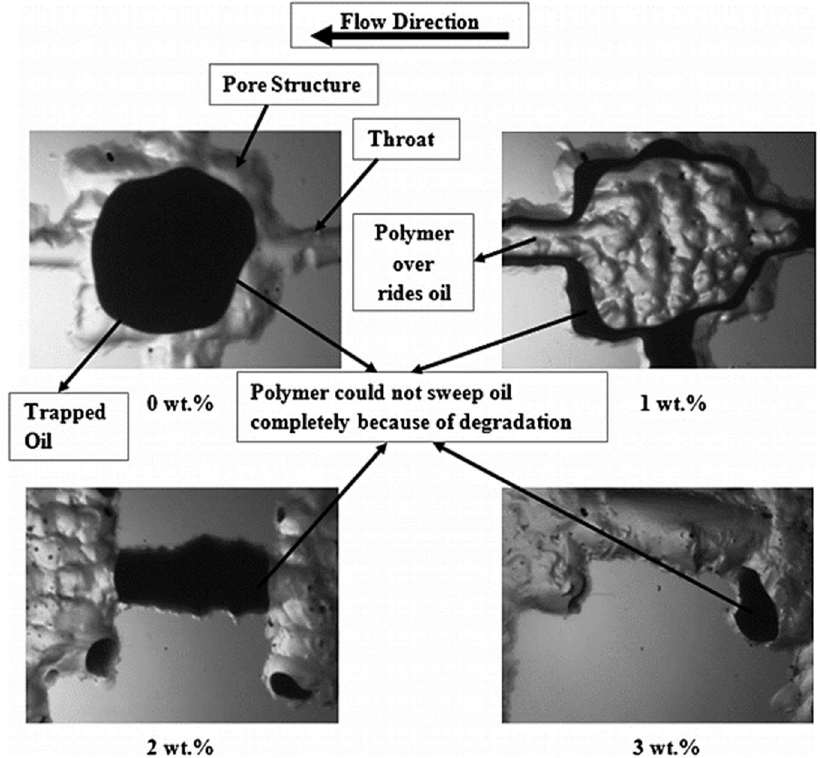
Figure 6. Glass micromodel picture of the oil displacement process with nano-polymer solution at different NP concentrations. Reproduced with permission from reference [83]. Copyright 2013 Taylor & Francis.